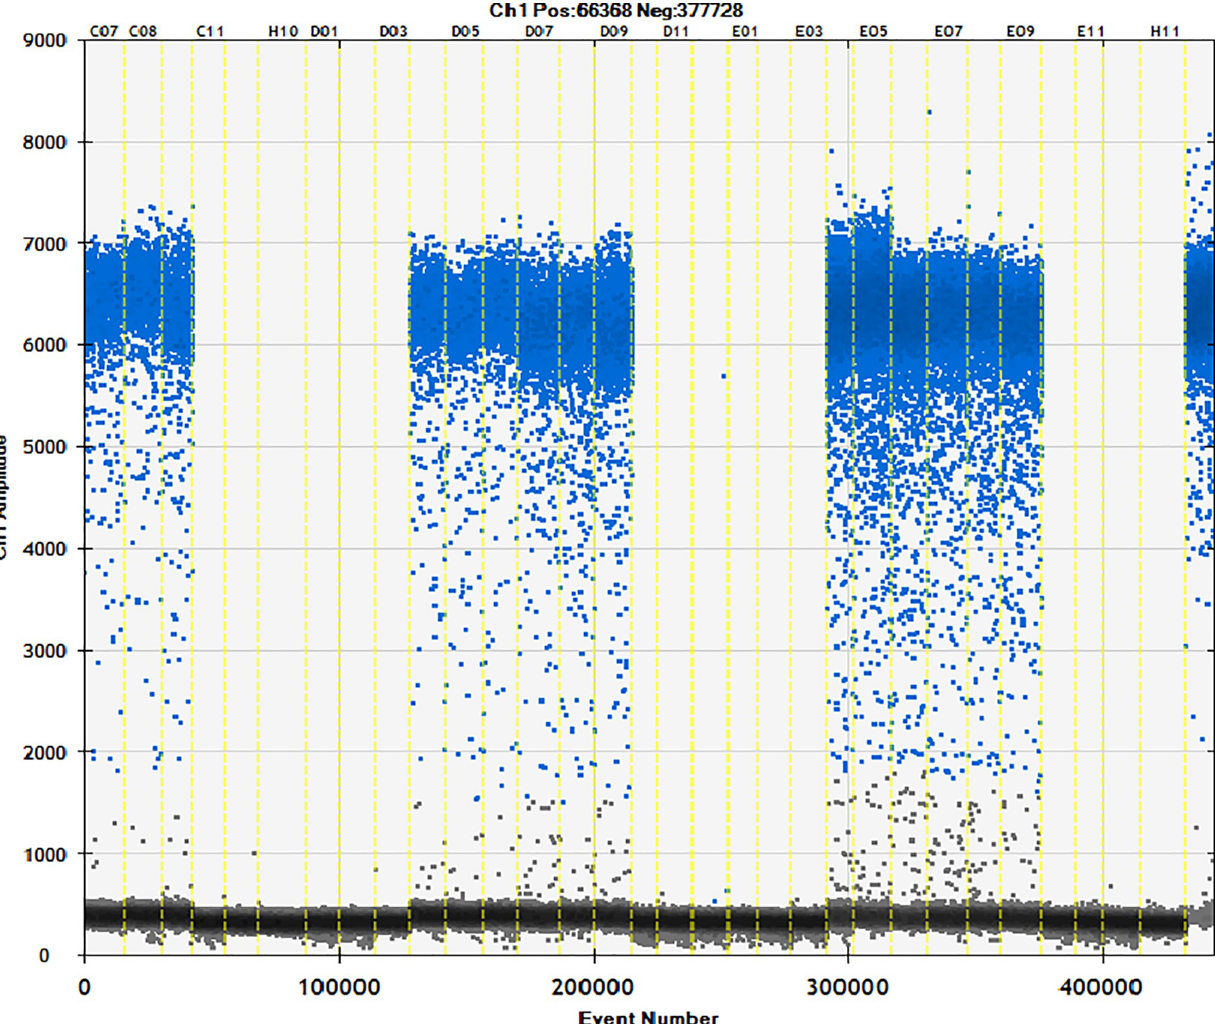
Fig 7. Actual test of commercially available samples. Channel 1–3: sample11; channel 4–6: sample12; channel 7–9: sample13; channel 10–12: sample14; channel 13–15: sample15; channel 16–18: sample16; channel 19–21: sample17; channel 22–24: sample18; channel 25–27: sample19; channel 28–30: sample20; channel31 negative; channel32